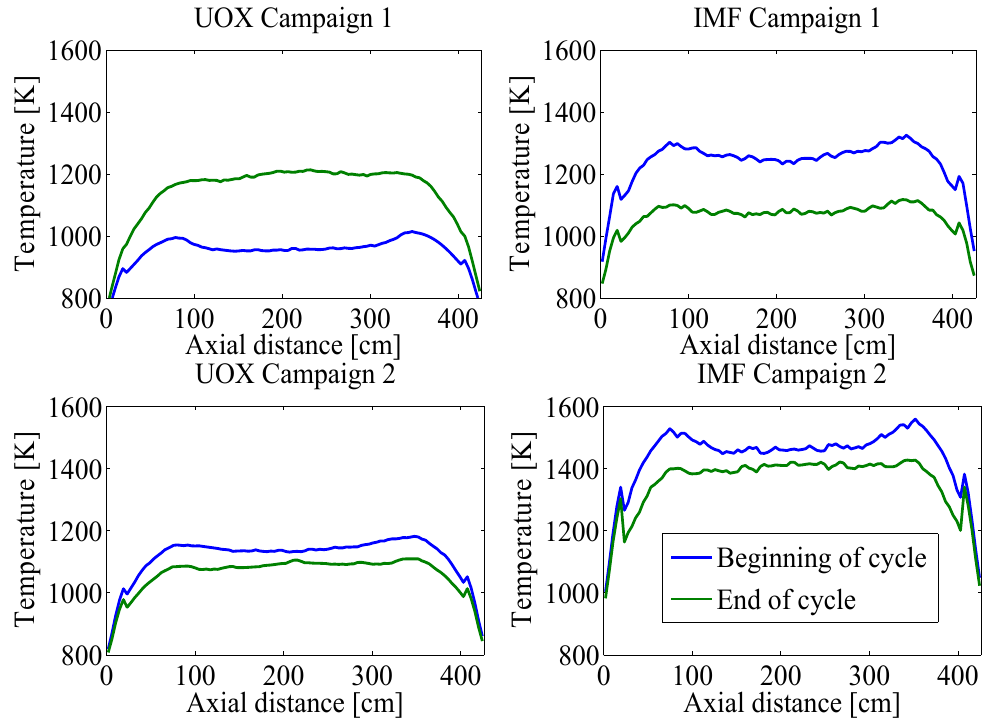
Figure 8. Axial temperature profile. The axial temperatures of the four assemblies in Figure 7 at the beginning and end of